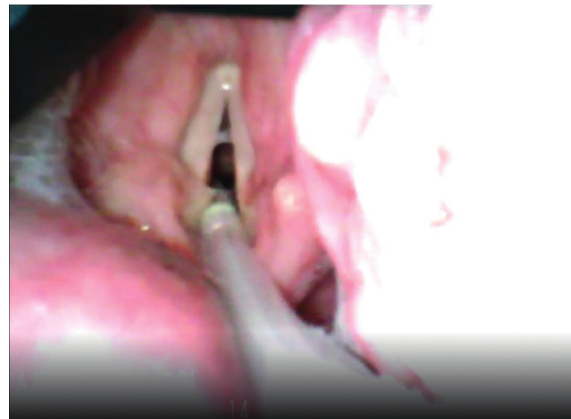
Figure 4: Flexible-tipped bougie in neutral